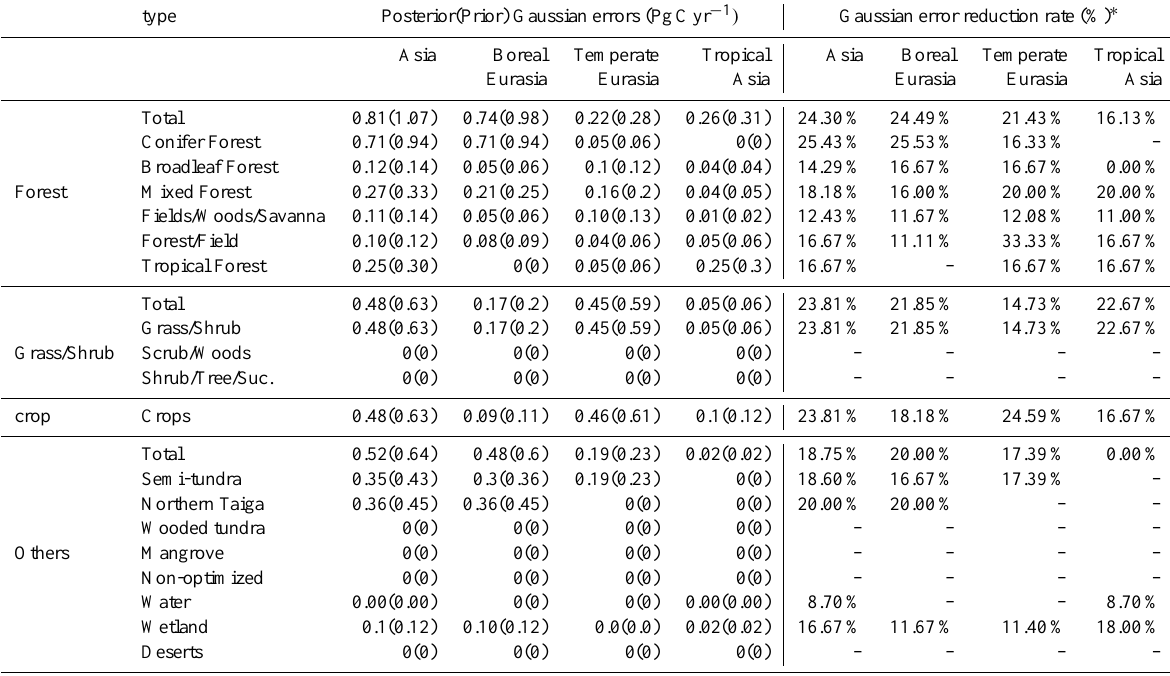
Table 5. The posterior/prior Gaussian errors (1-sigma) as well as the error reduction rate for the ecosystem types for